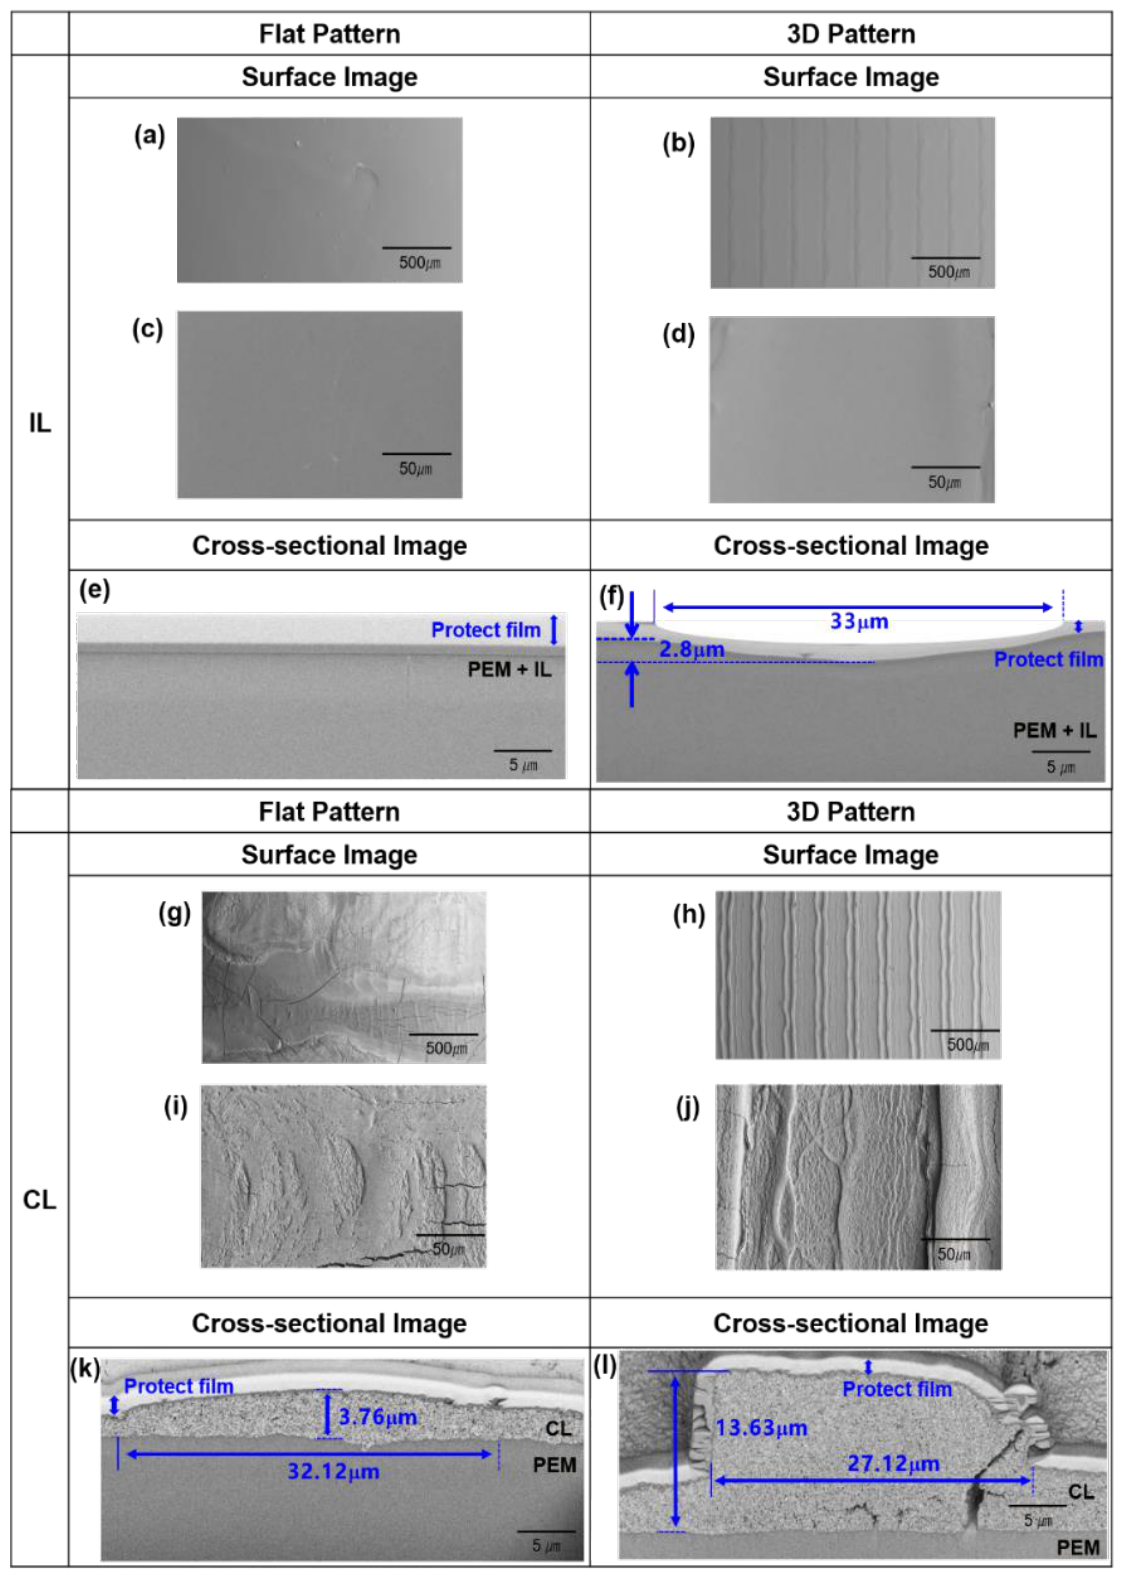
Figure 4. Surface SEM images at the 500 μ m ( a , b , g , h ) and 50 μ m ( c , d , i , j ) scales and cross-sectional ( e , f , k , l ) SEM images of the flat- and 3D-patterned structures in each IL and CL. Table 2. CCLs with flat and 3D patterns at the CL and IL.